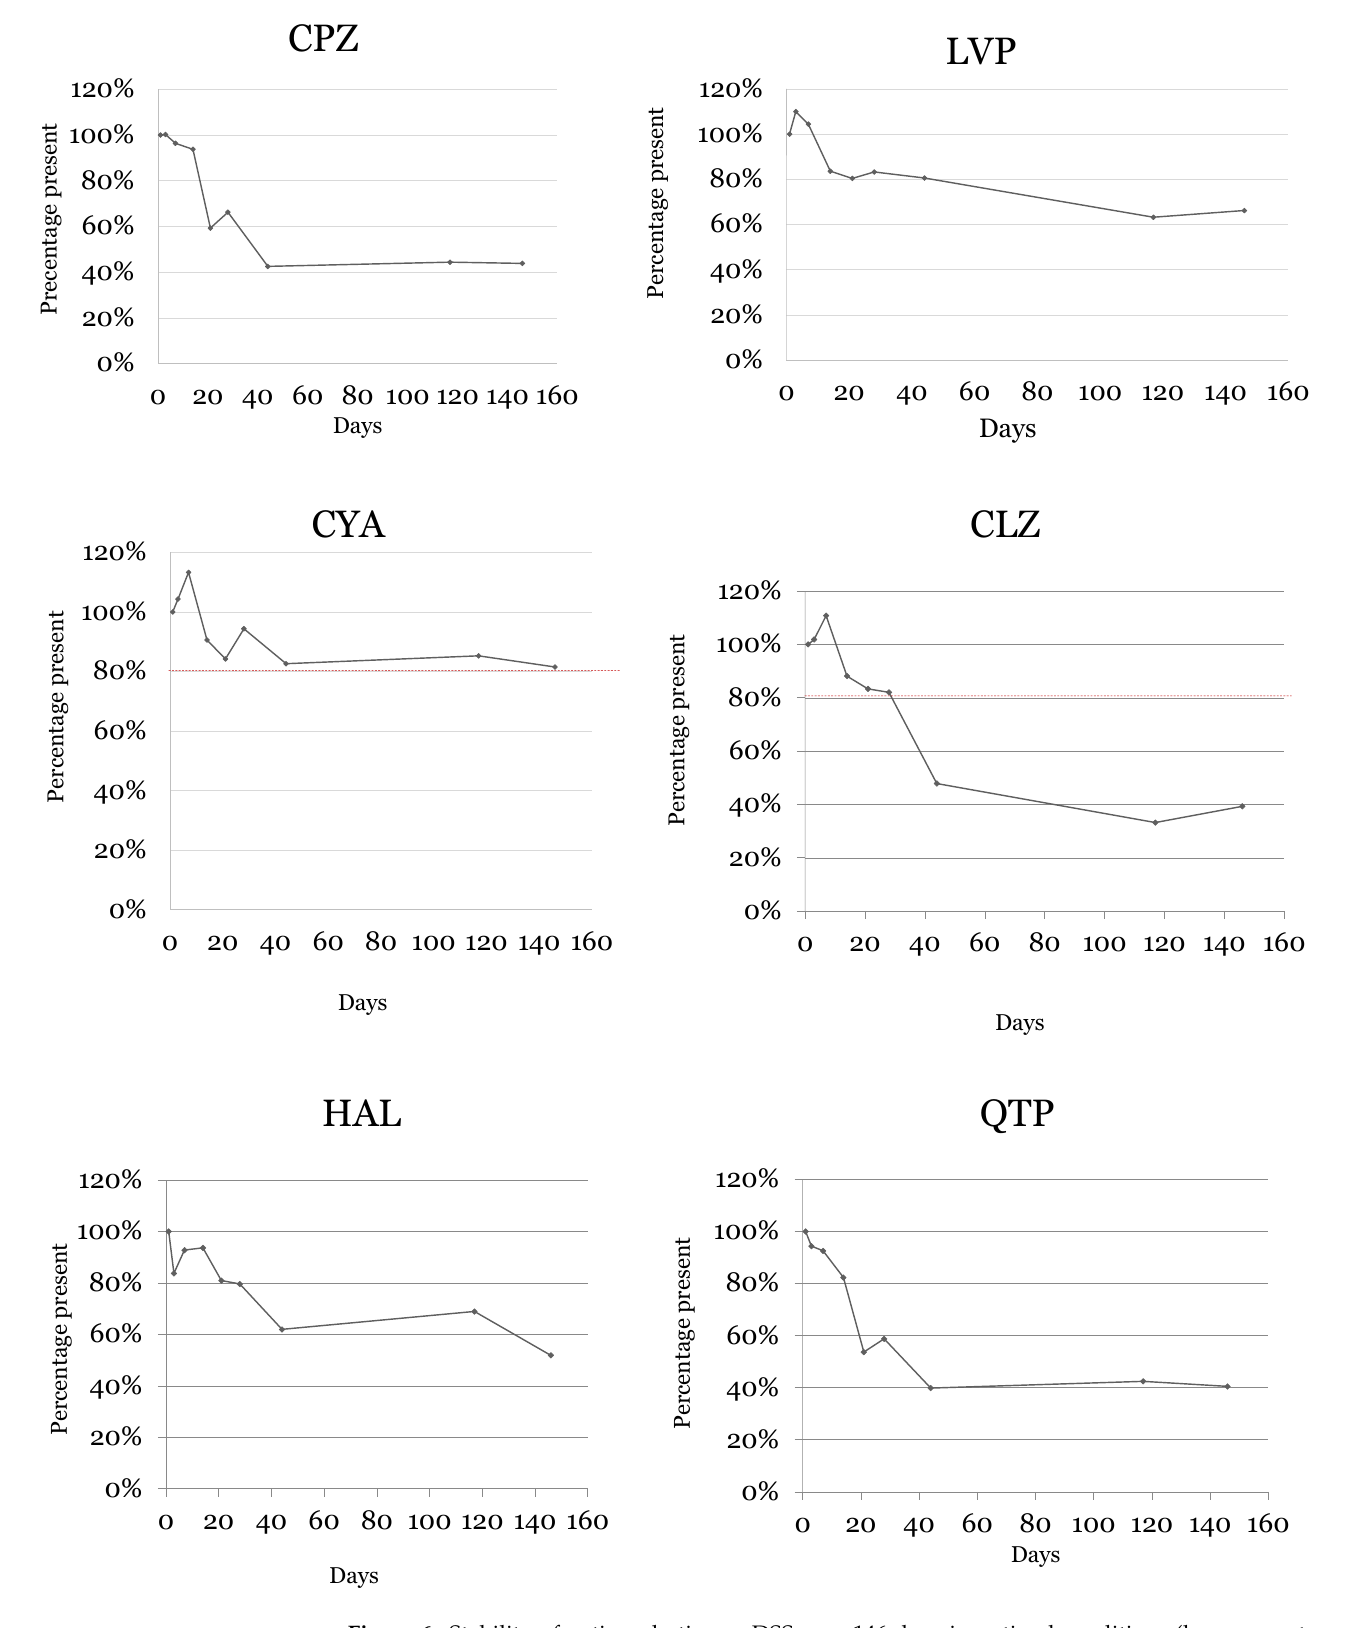
Figure 6. Stability of antipsychotics on DSS over 146 days in optimal conditions (low concentration of ascorbic acid, absence of light, and 4 °C). CPZ — chlorpromazine, LVP — levomepromazine, CYA — cyamemazine, CLZ — clozapine, HAL — haloperidol, QTP — quetiapine.